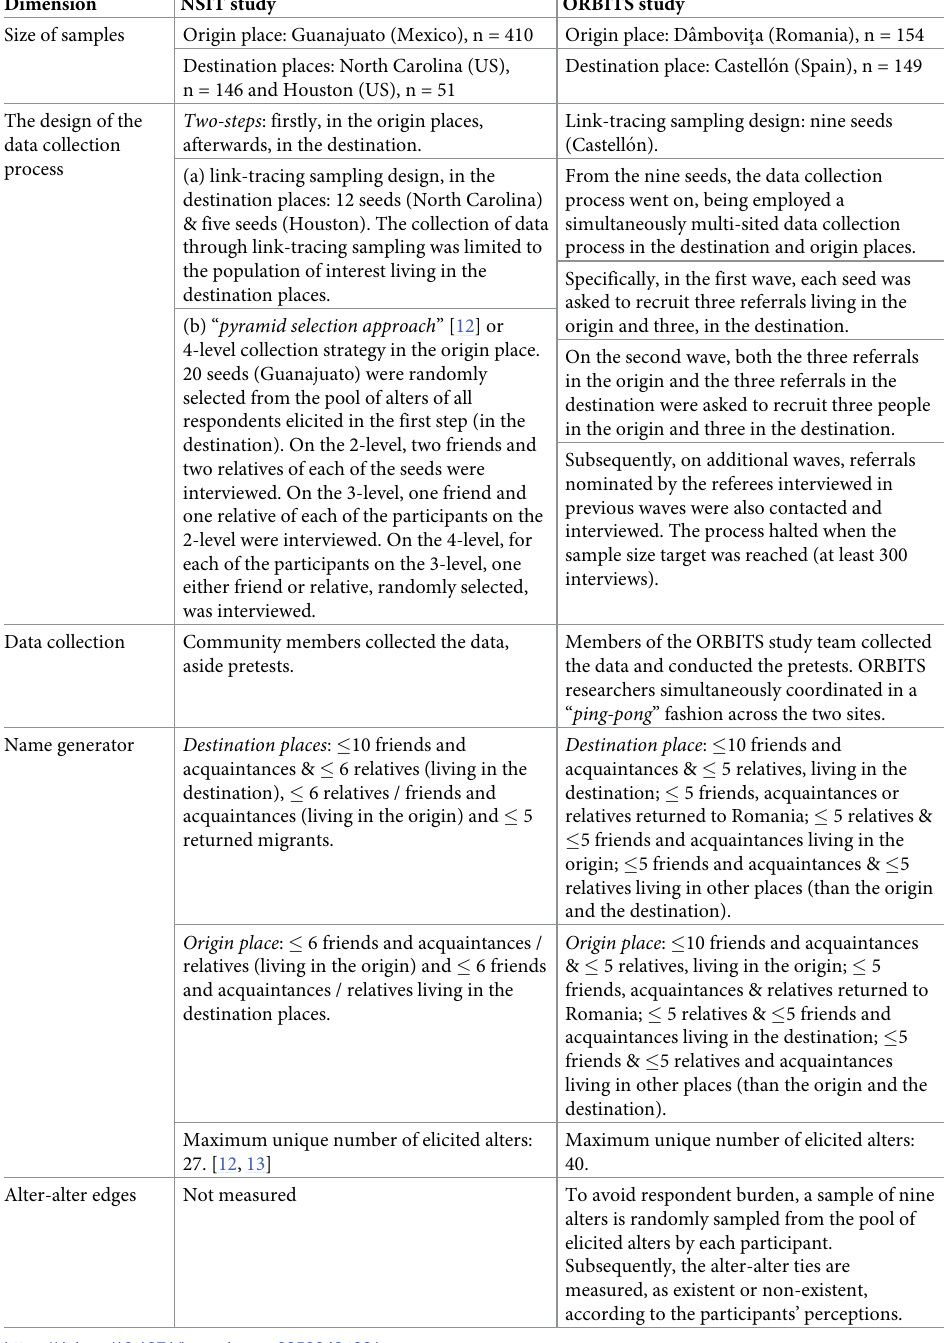
Table 1. Methodological differences between NSIT and ORBITS